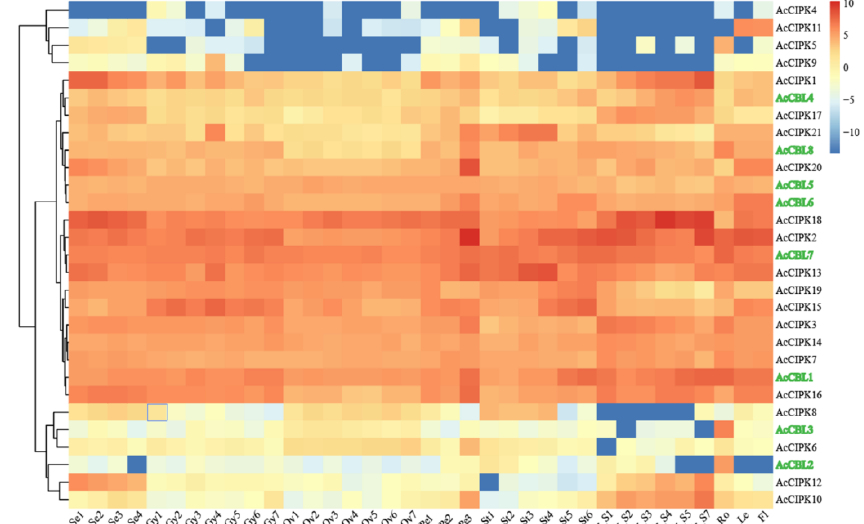
Figure5. ExpressionprofilesofthepineappleCBLandCIPKgenes. Hierarchicalclusteringofexpression Figure 5. Expression profiles of the pineapple CBL and CIPK genes. Hierarchical clustering of profiles of pineapple CBL-CIPK genes in di ff erent organs and developmental stages. Red color indicates expression profiles of pineapple CBL-CIPK genes in different organs and developmental stages. Red high levels of transcript abundance, and blue color indicates low transcript abundance. The color scale color indicates high levels of transcript abundance, and blue color indicates low transcript is shown at right side of the figure. Sample details are mentioned at the bottom of each lane: sepal abundance. The color scale is shown at right side of the figure. Sample details are mentioned at the Se1–Se4, gynoecium Gy1- Gy7, ovule Ov1–Ov7, petal Pe1–Pe3, stamen St1–St6, fruit ‘Fr_S1–Fr_S7’, root bottom of each lane: sepal Se1–Se4, gynoecium Gy1- Gy7, ovule Ov1–Ov7, petal Pe1–Pe3, stamen ‘Ro’, leaf ‘Le’, and flower ‘Fl’. Where ‘S’ is the abbreviation for ‘stage’. Pineapple CBL gene names are St1–St6, fruit ‘Fr_S1– Fr_S7’, root ‘Ro’, leaf ‘Le’, and flower ‘Fl’. Where ‘S’ is the abbreviation for represented in green ‘stage’. Pineapple CBL gene names are represented in green color.